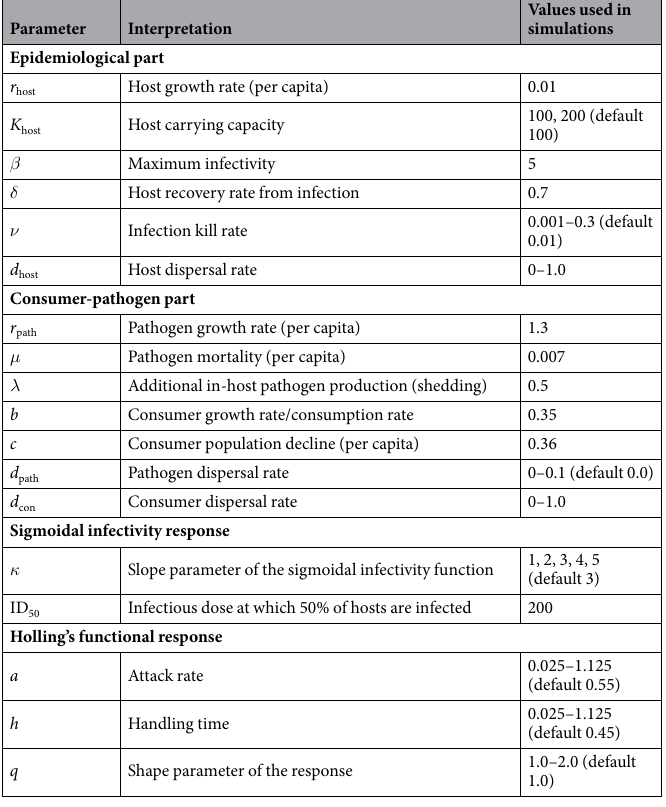
Table 1. A table of model parameters, their explanations and parameter values that are used in the